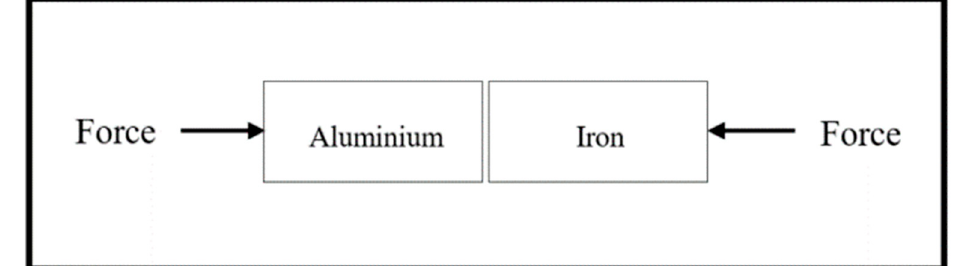
Figure 1. Diagram of Specimens Assembly .